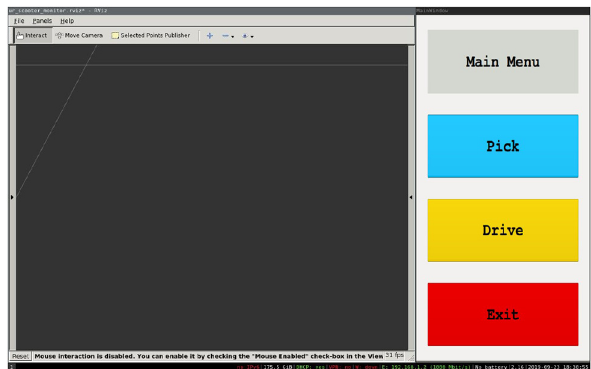
Figure 5: Main Menu of the GUI. From here the user can either drive the scooter or begin a pick